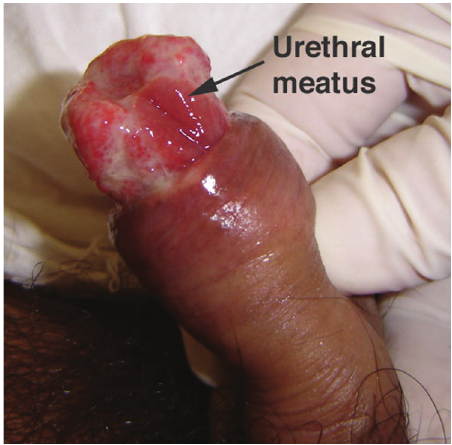
Figure 1 – An ulcerated lesion surrounding the urethral meatus